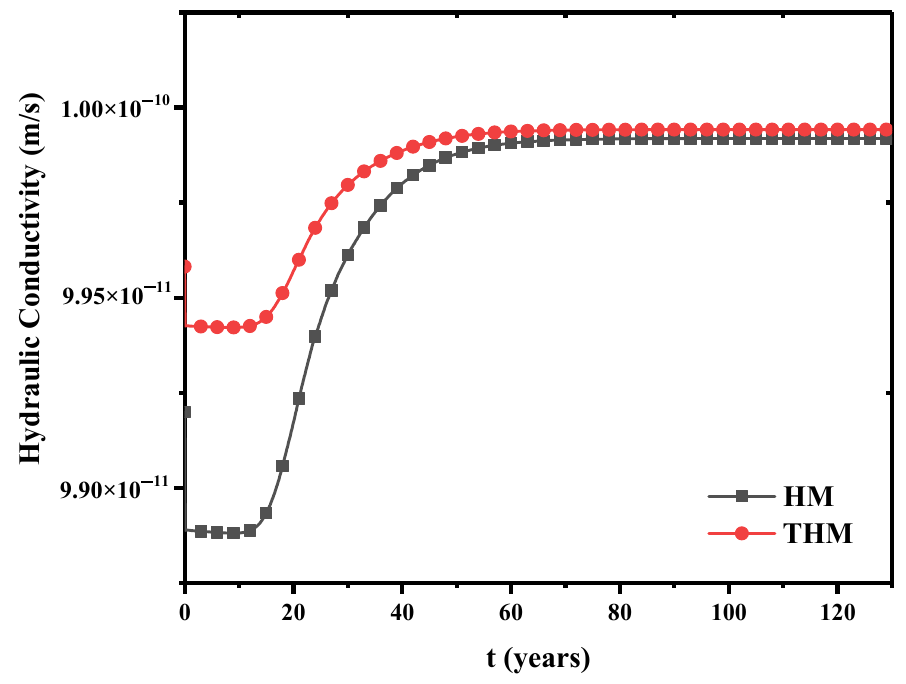
Figure 13. The e ff ect of temperature on hydraulic conductivity. Figure 13. The effect of temperature on hydraulic conductivity.